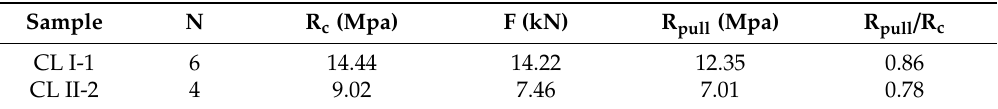
Table 3. Pull-out test